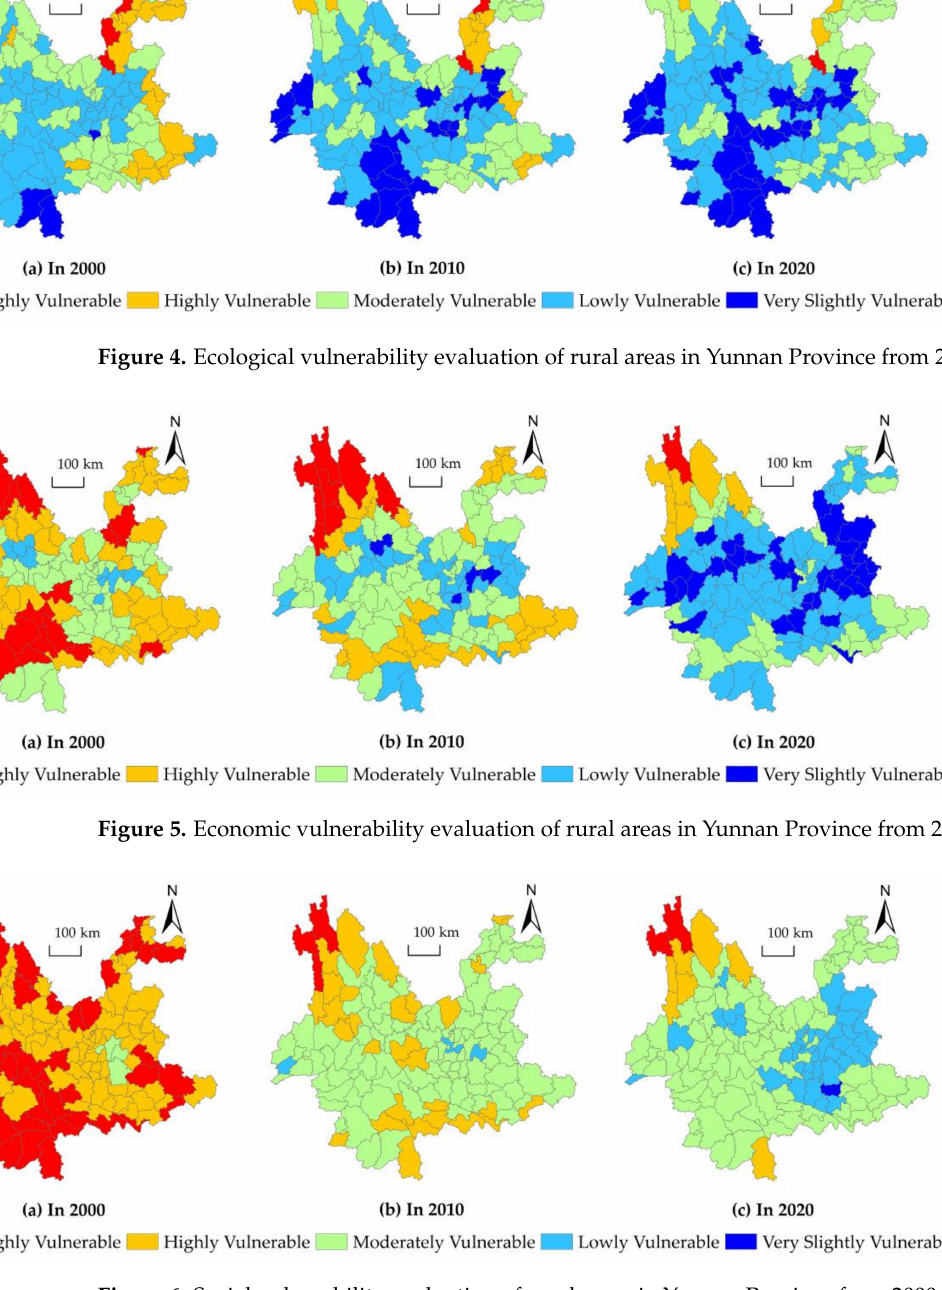
Figure 6. Social vulnerability evaluation of rural areas in Yunnan Province from 2000 to